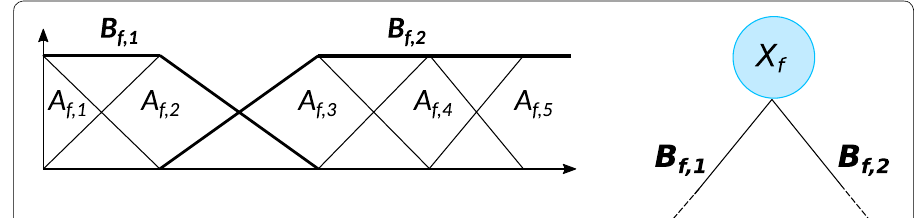
Fig. 9 An example of fuzzy binary